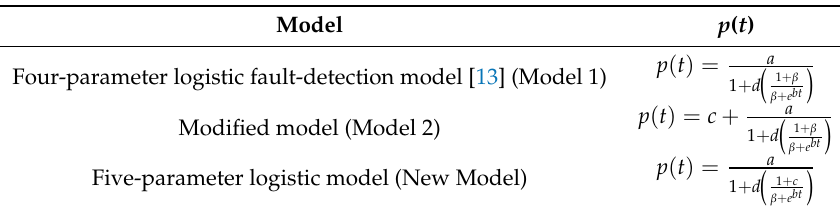
Model p ( t ) Four-parameter logistic fault-detection model [13] (Model 1) Modified model (Model 2) Five-parameter logistic model (New Model)